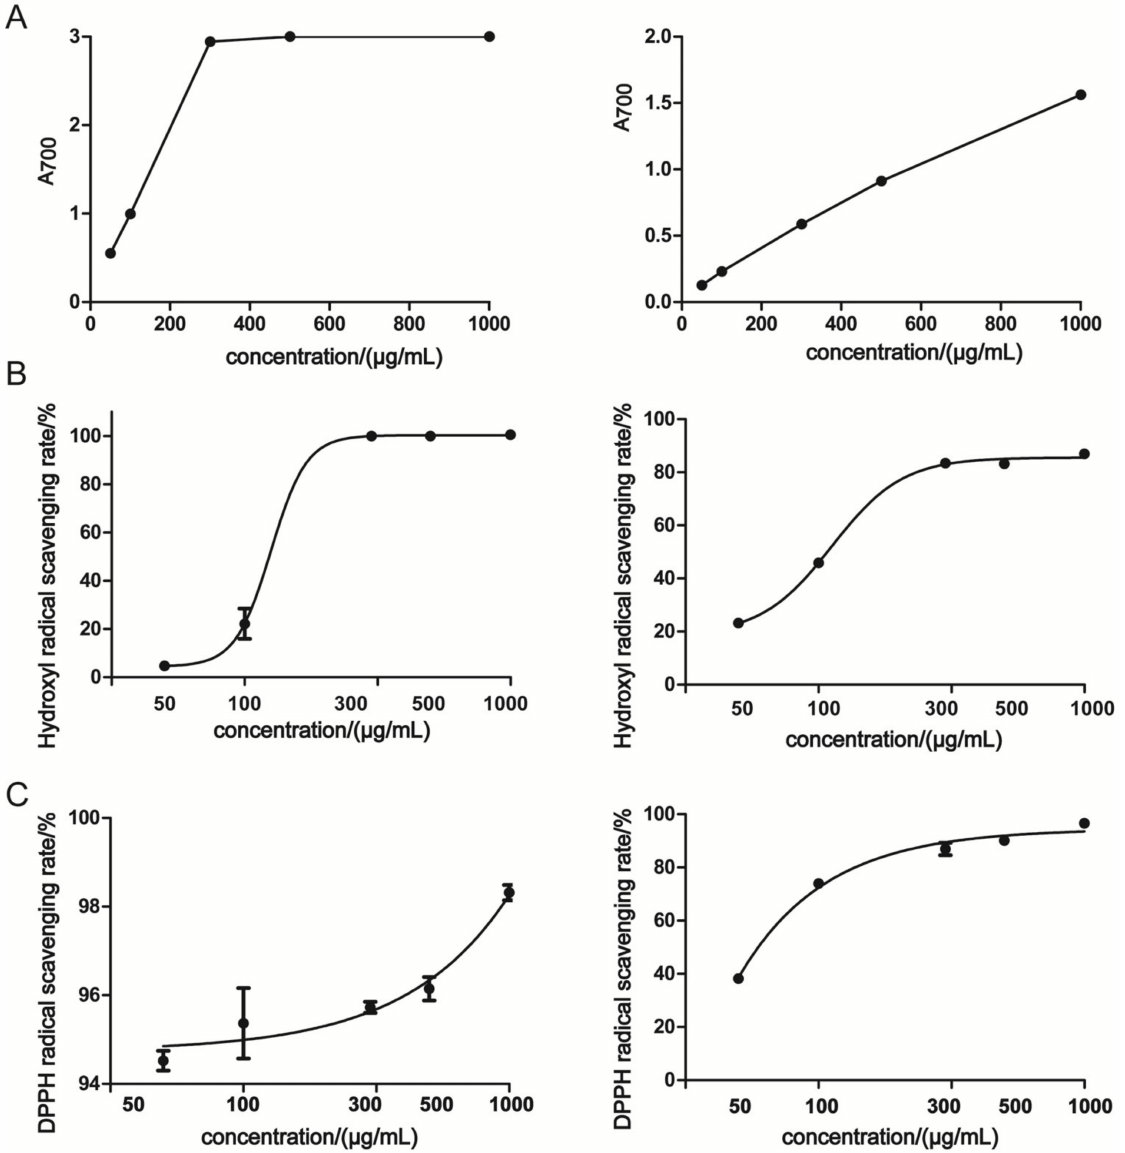
Figure 2. The antioxidant activities of OPA in vitro. ( A ) Ferric reducing power; ( B ) hydroxyl radical scavenging; ( C ) DPPH radical scavenging activity. The left was VC and the right was OPA. A 700 was the absorbance value at 700